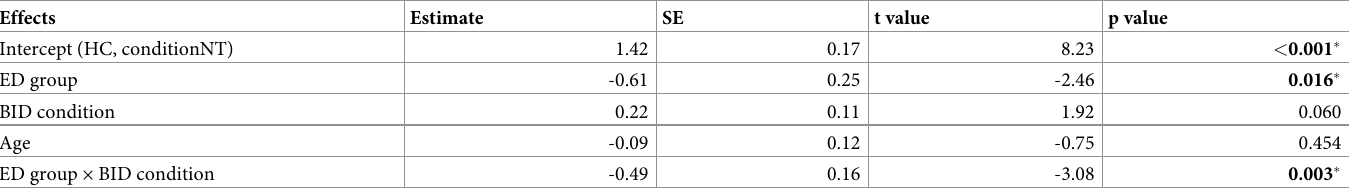
Table 7. Mixed effects linear regression analysis of model-based learning parameter β MB .